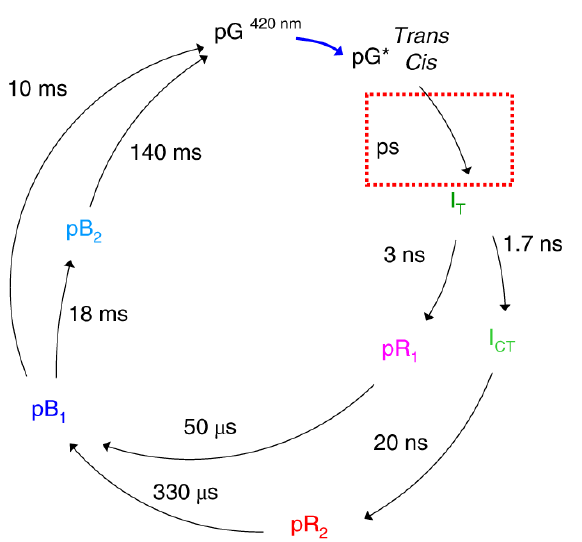
Figure 10. Photocycle of photoactive yellow protein. The red box highlights a region where previously unseen structural confirmations exist, as determined by spectroscopy. Figure originally published in Nat. Methods